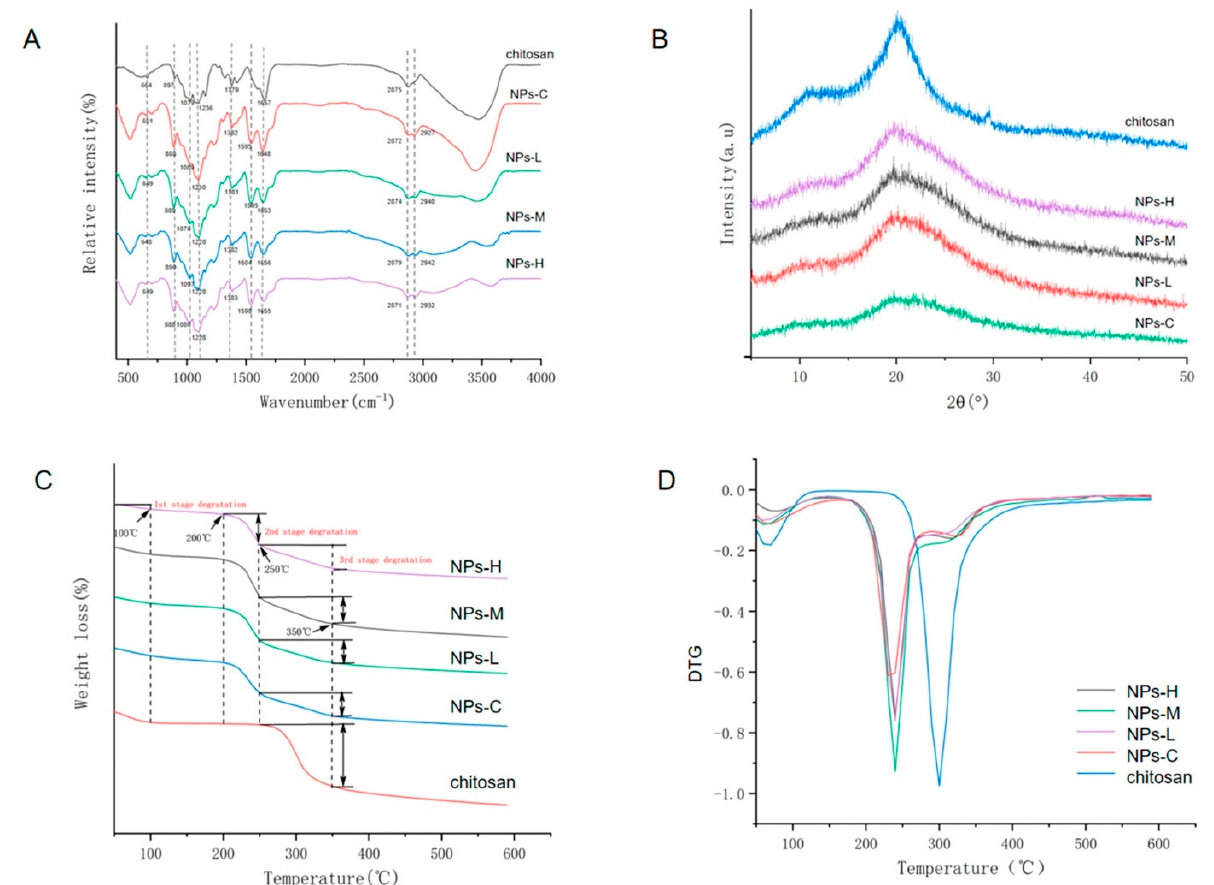
Figure 10. ( A ) FTIR results showing chitosan. ( B ) XRD analysis ( C ), TGA analysis ( D ), DTG analysis. The ratios of chitosan to MEO: (NPs-C = 1:0), NPs-L (1:0.25), NPs-M (1:0.5), NPs-H (1:1). Reproduced with permission from Song et al. [ 96 ]. Copyright 2021 Elsevier.